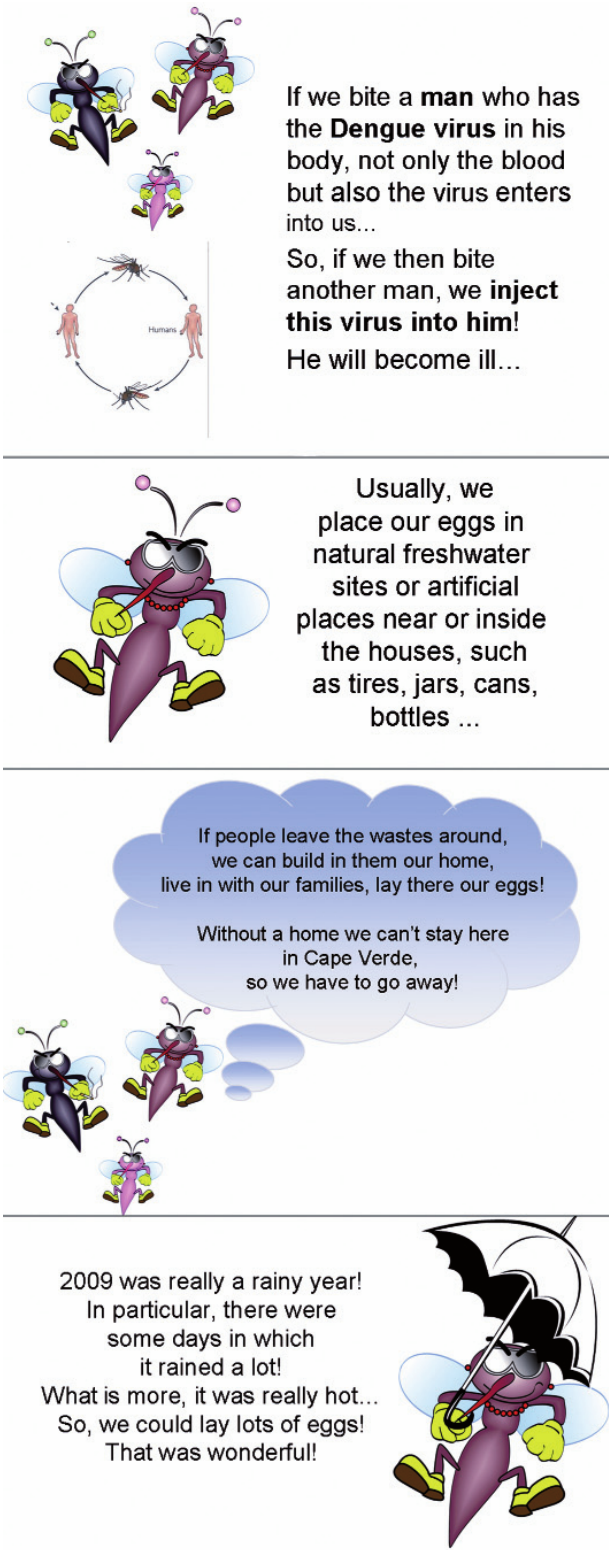
Figure 1. The mosquito Aedes aegypti , the vector of the dengue fever virus. Illustration of the mosquito life cycle, and the environmental conditions favorable to its development and its